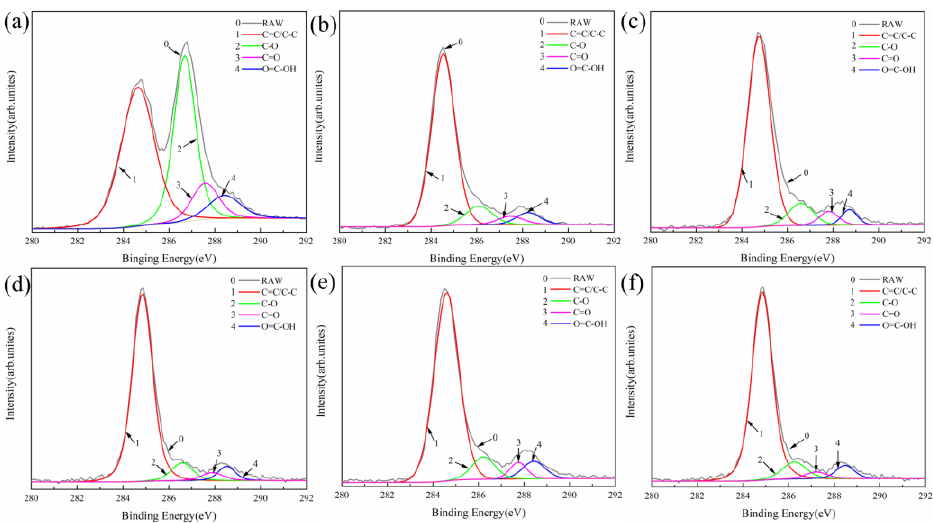
Figure 6. XPS C1s spectra of the ( a ) GO and Cu-Gr at ( b ) 120 s, ( c ) 180 s, ( d ) 240 s, ( e ) 300 s, and ( f ) 360 s. Table 2. The peak area (A) ratios of the oxygen-containing functional bonds to the C-C bonds of the GO and Cu-Gr samples with different deposition times.